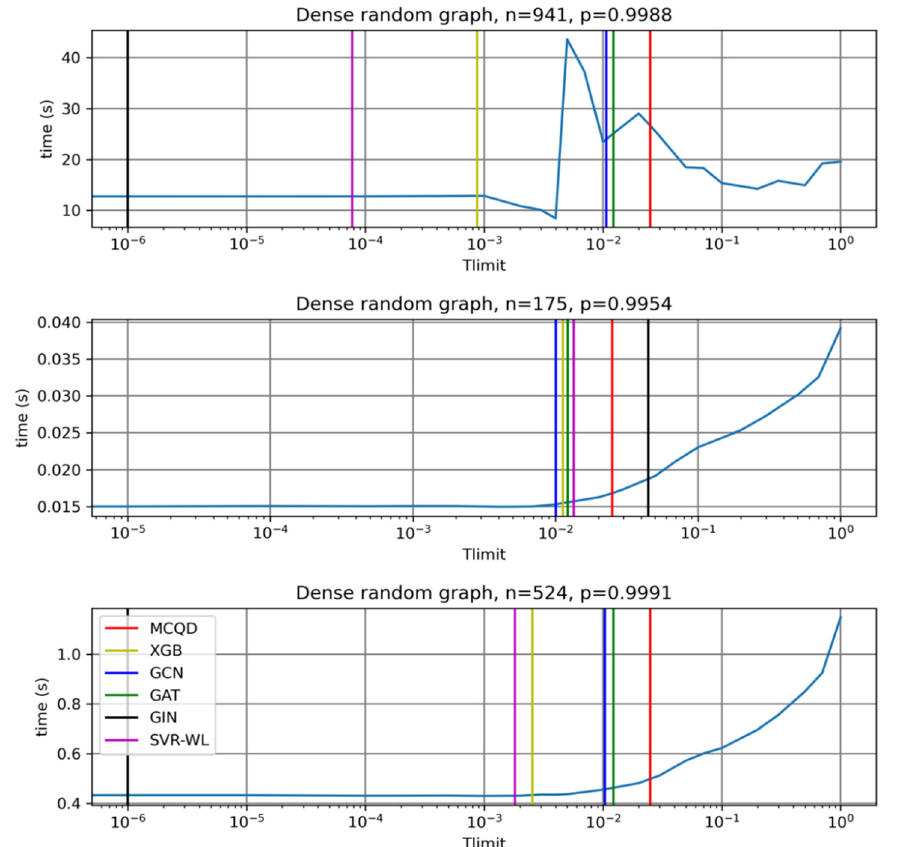
Figure 4. Time that MCQD algorithm and each variant of the MCQD-ML algorithm needs to find the maximum clique on three different graphs from a test set of dense random graphs dependent on the Tlimit parameter.